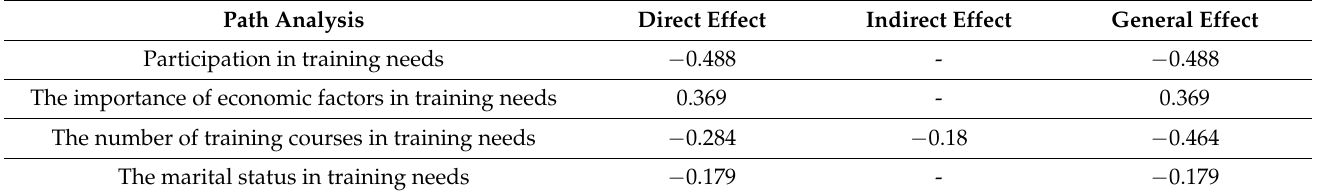
Table 6. Direct, indirect, and total effects in analyzing the training needs assessment of female rice farmers.